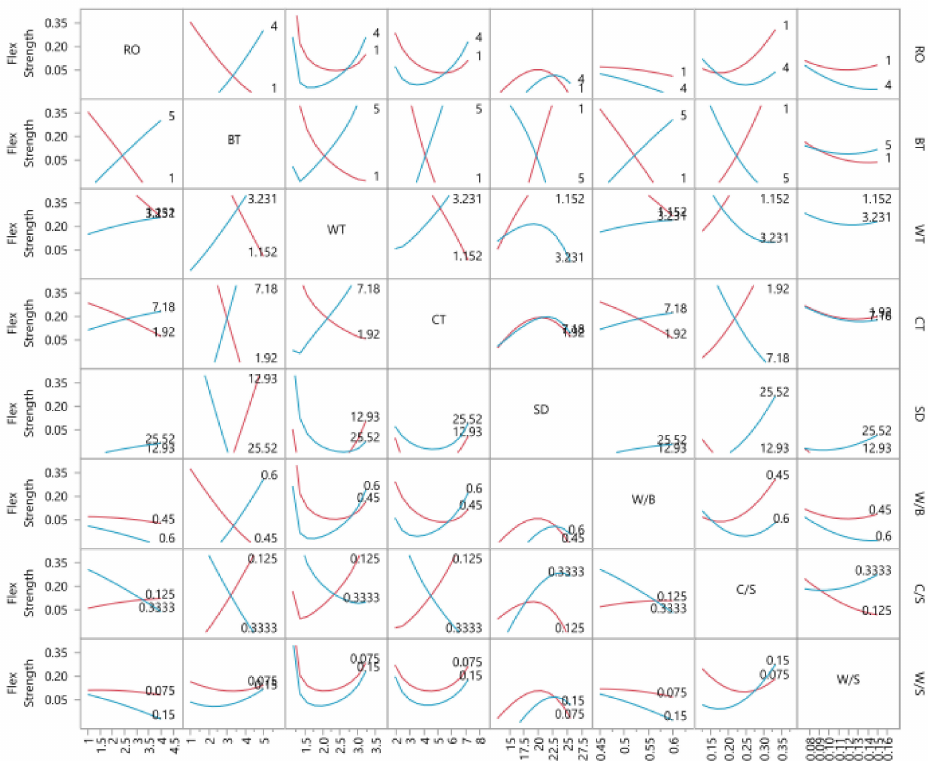
Figure 14. Interaction profile ranges for flexural strength with respect to